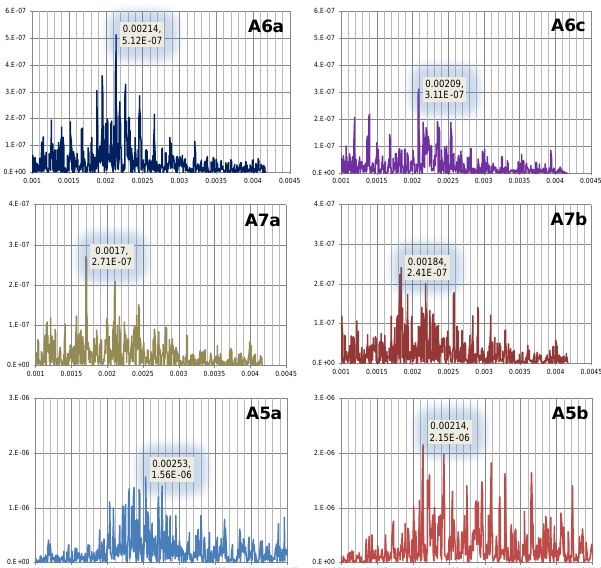
Figure 15. The power spectra, as a function of frequency in Hz, of the first derivative of the average temperature during A6a, A6c (both with the bar at 2m, top), A7a, A7b (both with the bar at 1.5m, middle), A5a, and A5b (both with the bar at 1m, bottom). Each maximum is supplied with the frequency and the power.